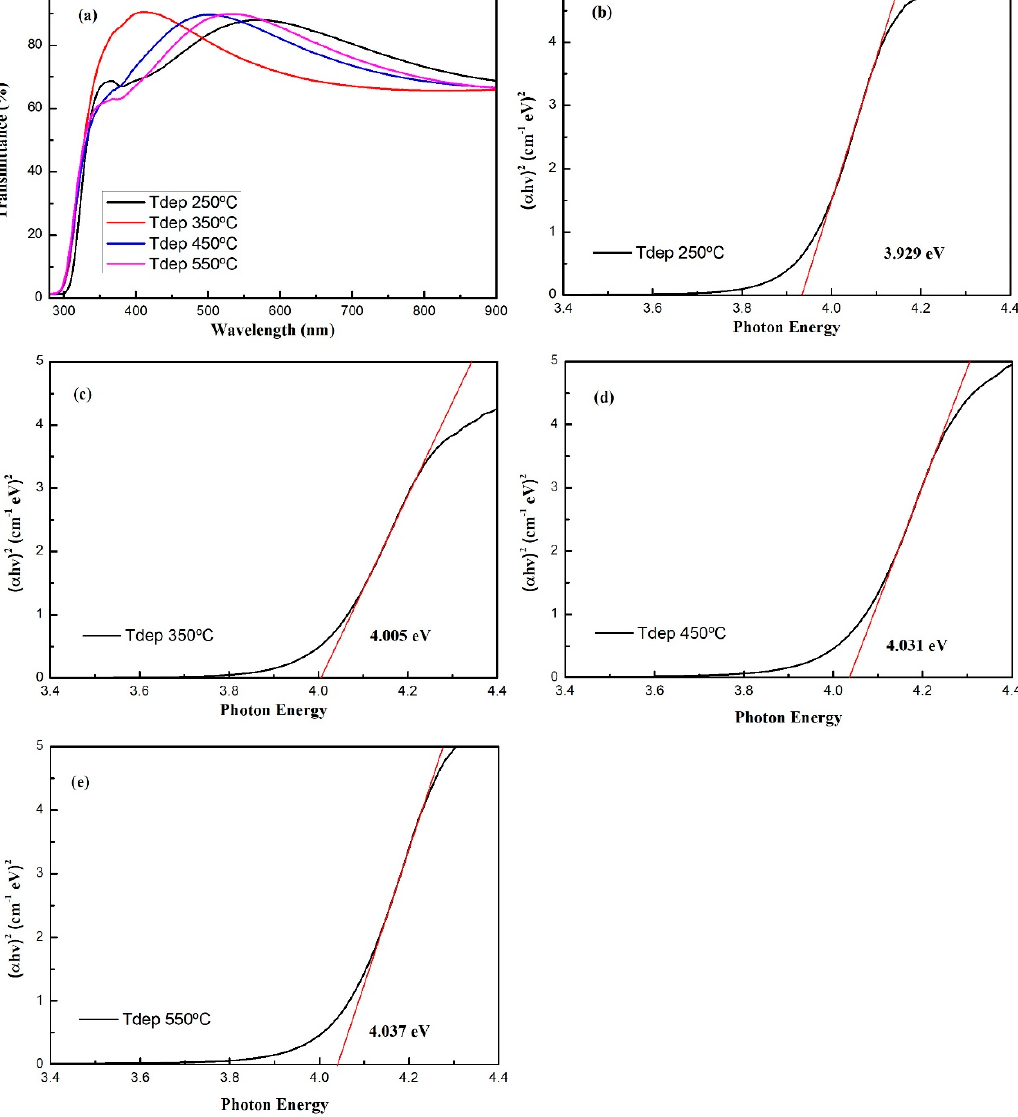
Figure 3. ( a ) Transmittance spectrum of ZrO 2 thin films at different annealing temperature. ( b–e ) Band gap was determined by optical method using ( α h ν ) 2 versus h ν plots.